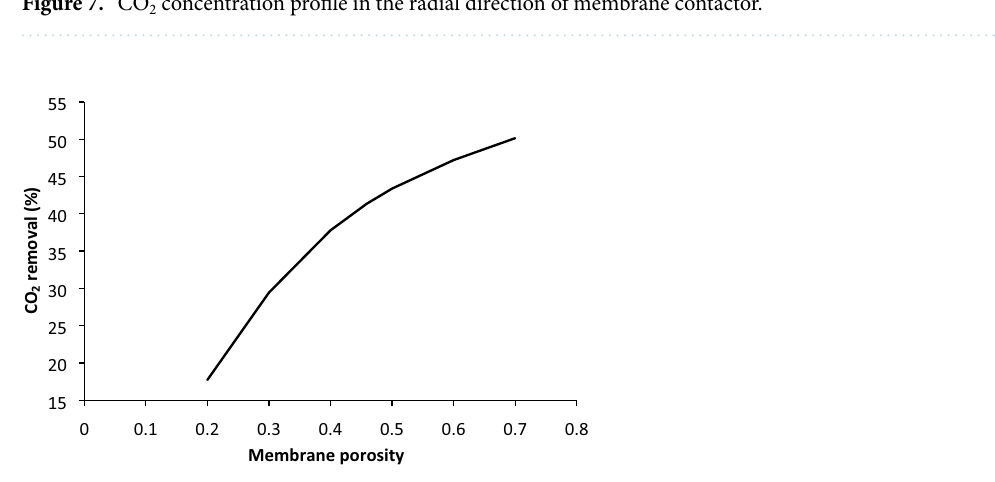
Figure 7. CO 2 concentration profile in the radial direction of membrane contactor.